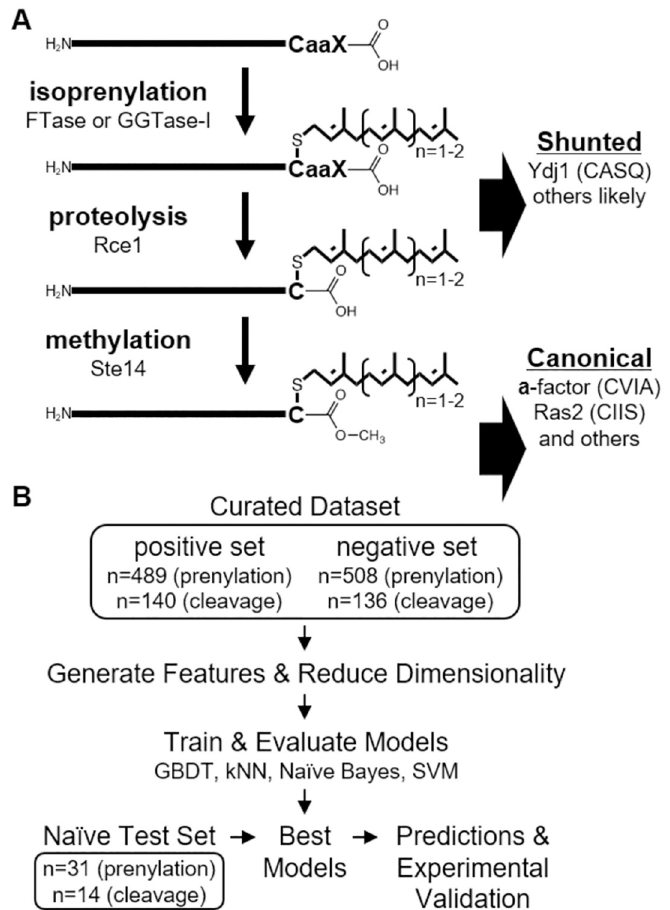
Fig 1. Biochemical and machine learning workflow diagrams. A) Modifications occurring to CAAX proteins. Isoprenylation involves attachment of a farnesyl (C15) or geranylgeranyl (C20) lipid to the consensus cysteine